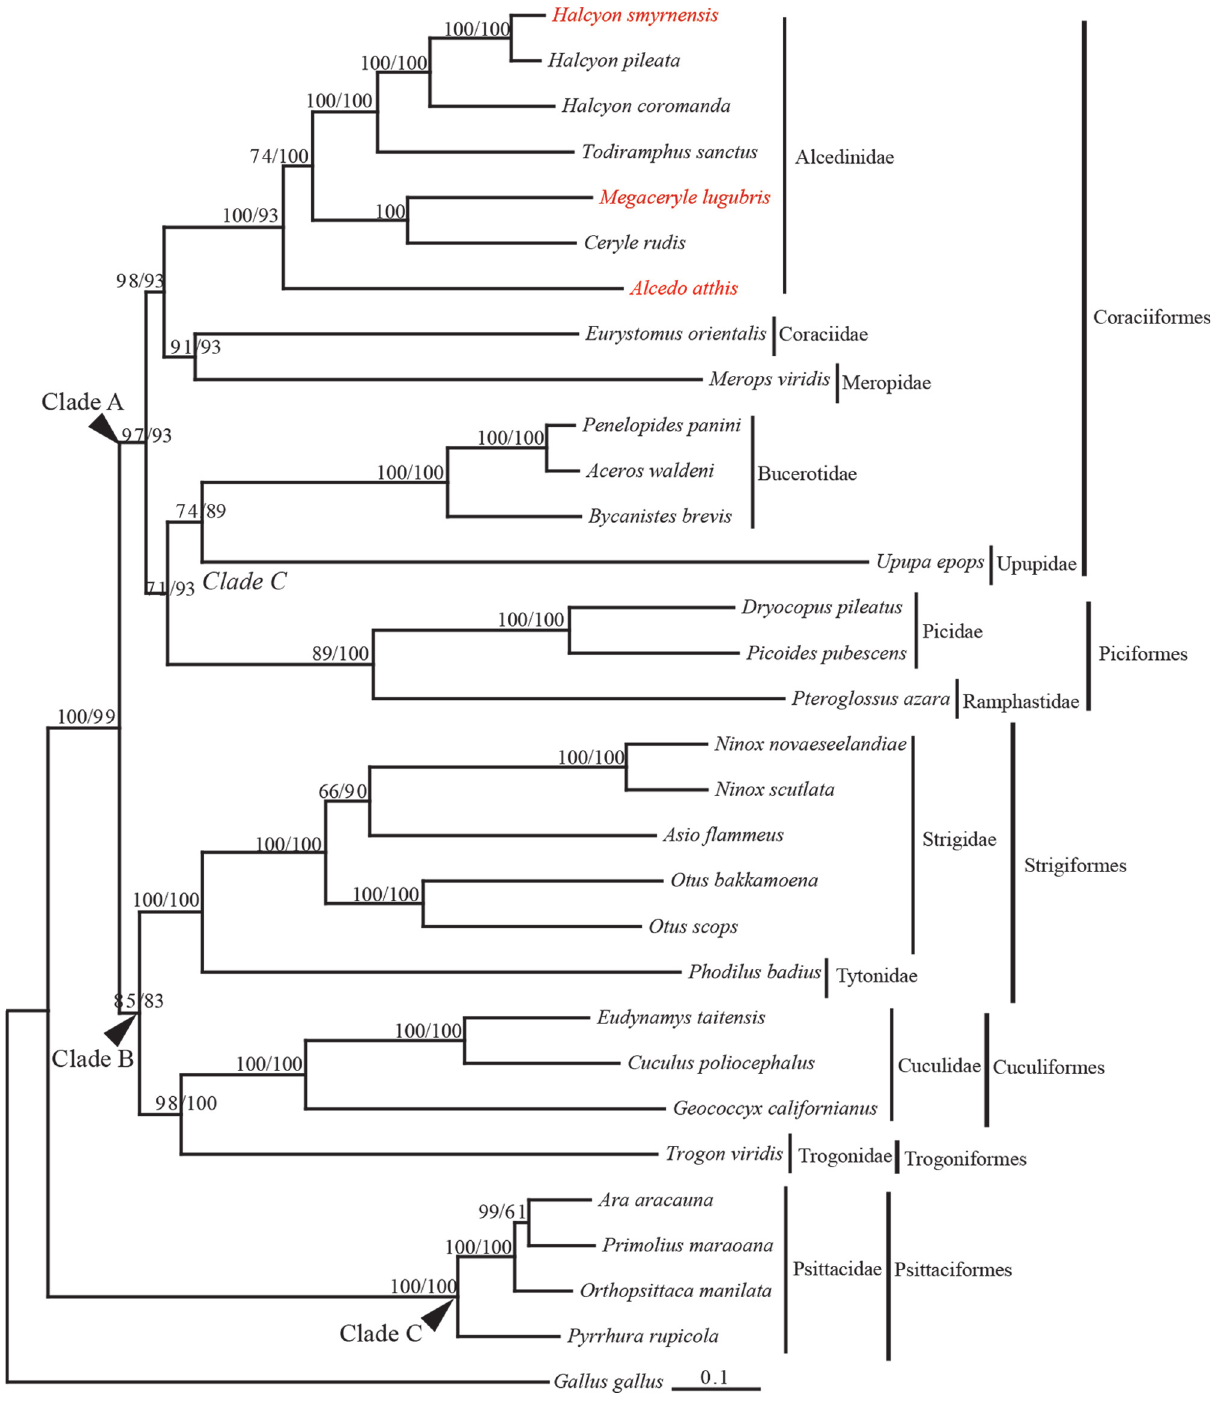
Figure 2 - Phylogenetic tree of 30 species from 12 families of six orders with G. gallus as outgroups. Analyses were based on mitogenome sequences without control regions and the sequences of 12 PCGs without MT-ND6. The Bayesian posterior probability (PP) values for each node were presented. Values for the first set of data were listed in front of those for the second set of